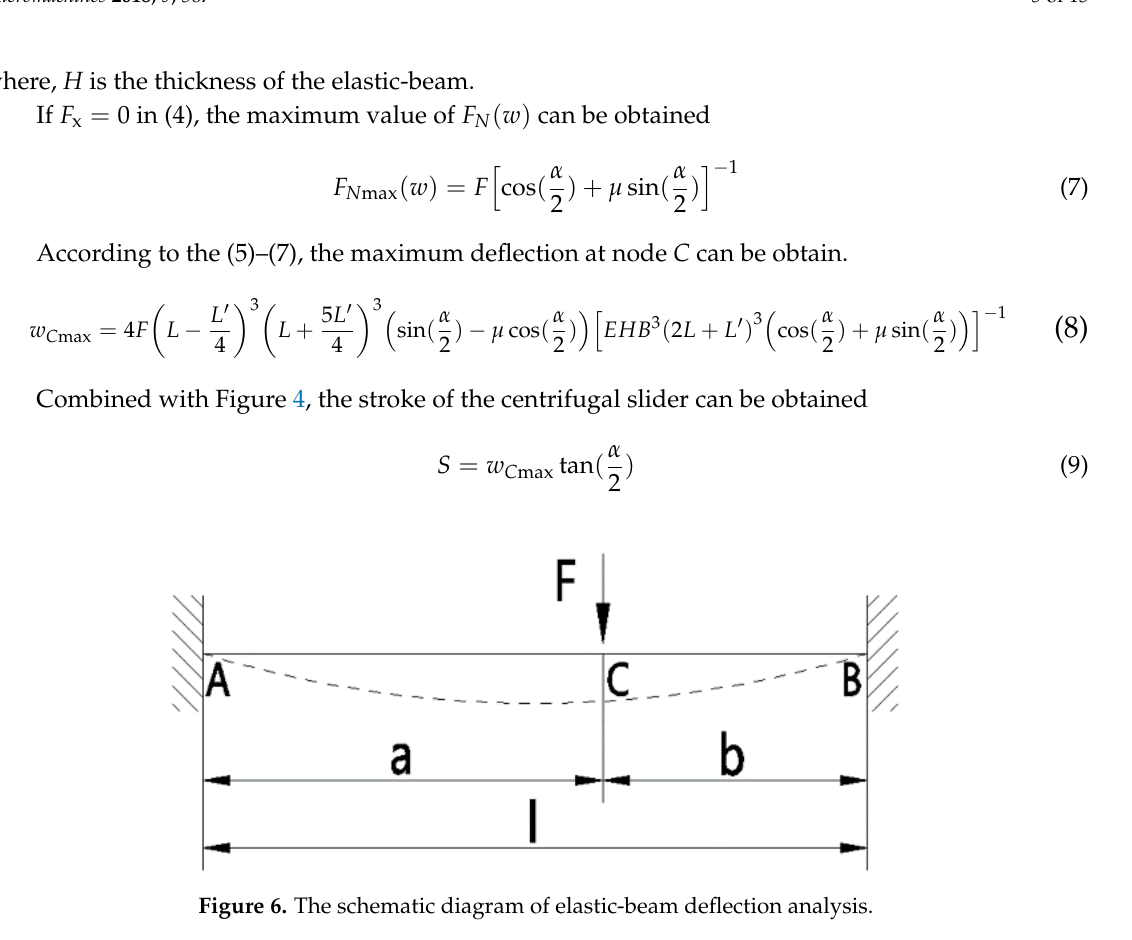
Figure 7. The schematic diagram of kinematic analysis and time estimating.